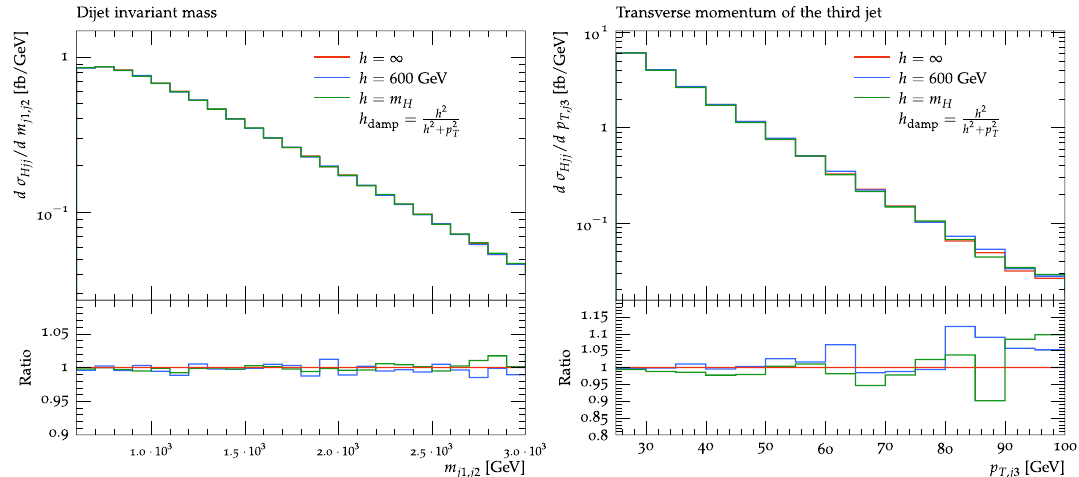
Fig. 6 Invariant-mass distribution of the two tagging jets (left) and transverse-momentum distribution of the third jet (right) within the cuts of Eqs. (3)–(4) at NLO + PS accuracy for the POWHEG-BOX , matched